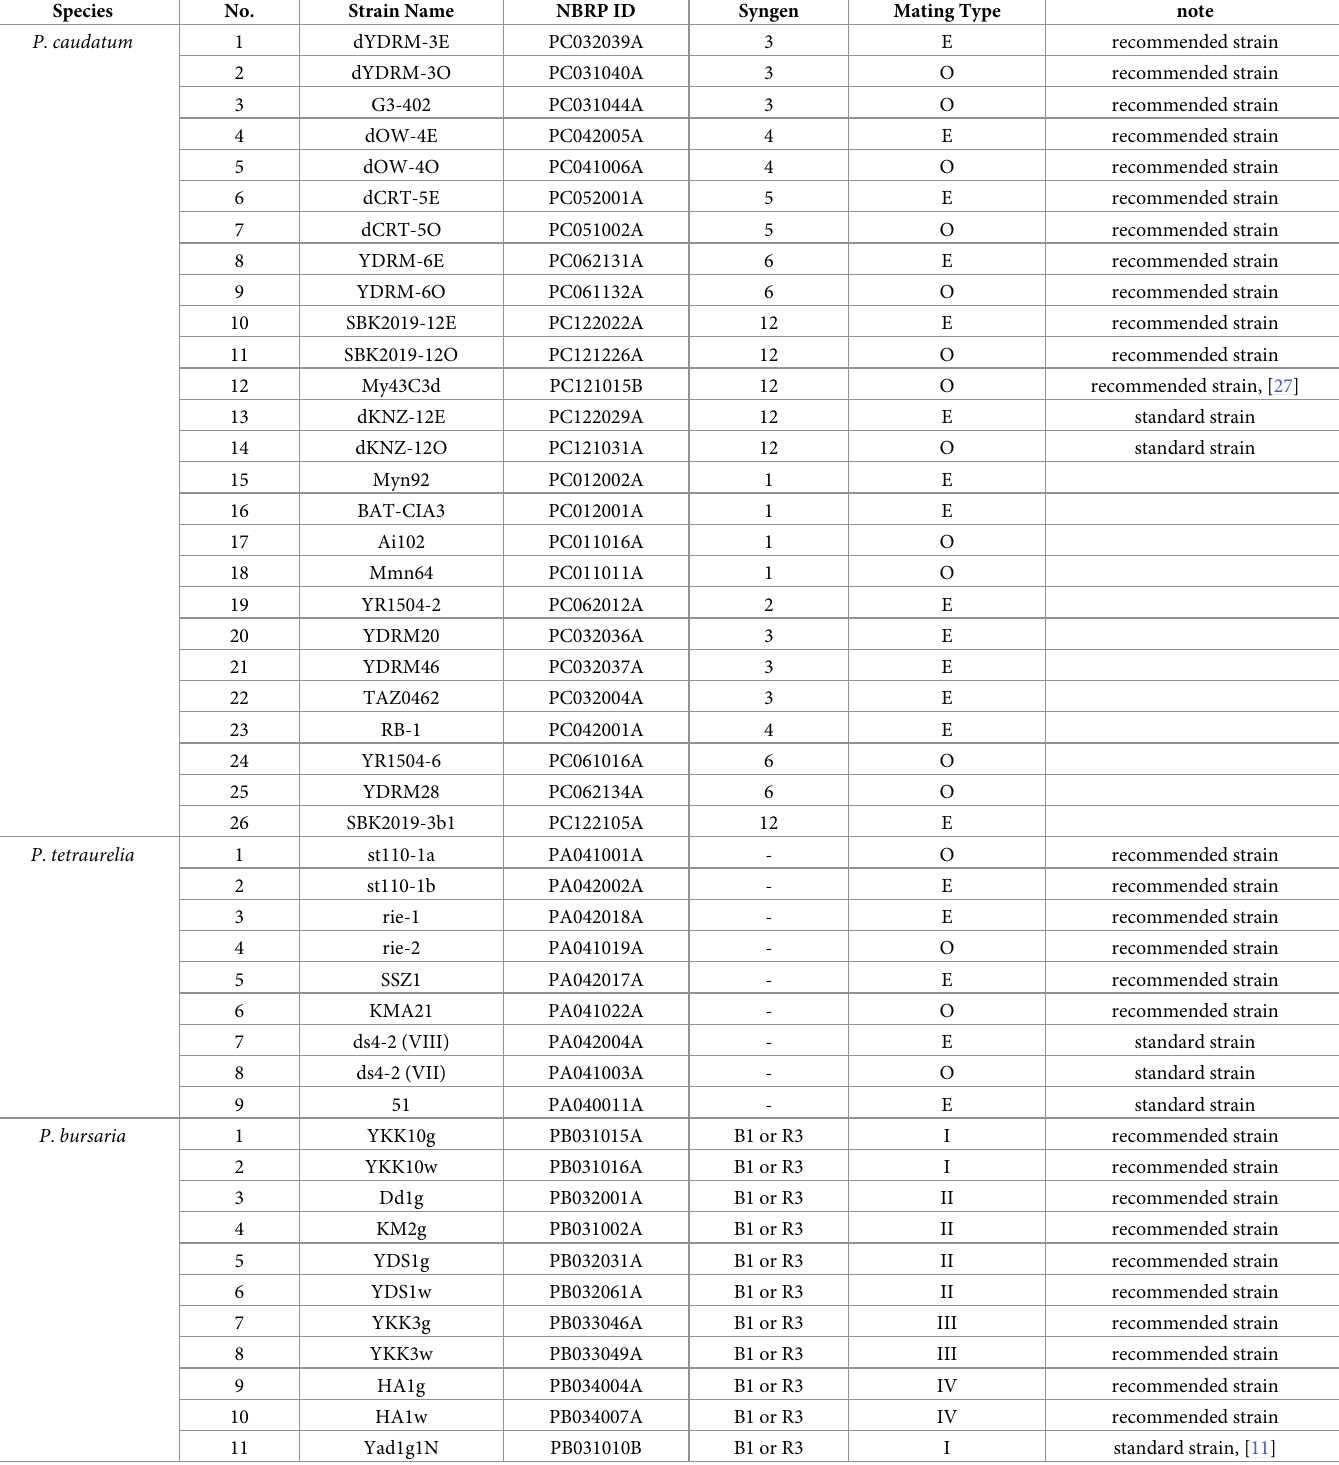
Table 1. List of Paramecium strains used in this study.